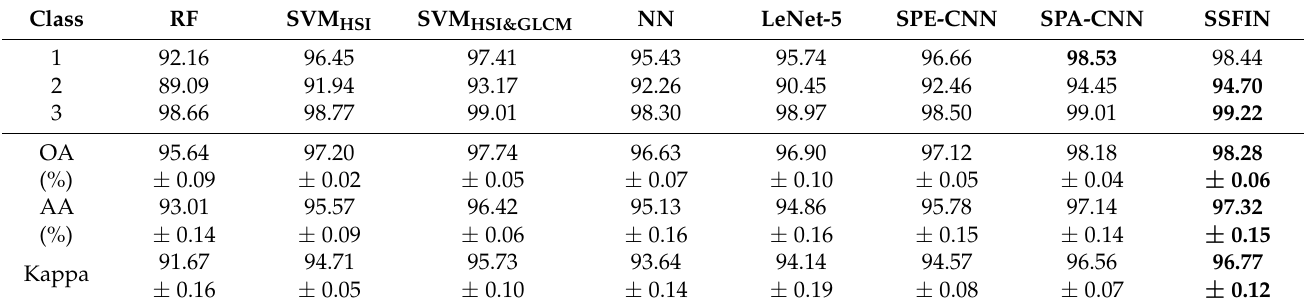
Table 7. Classification results of different methods for dataset 1.